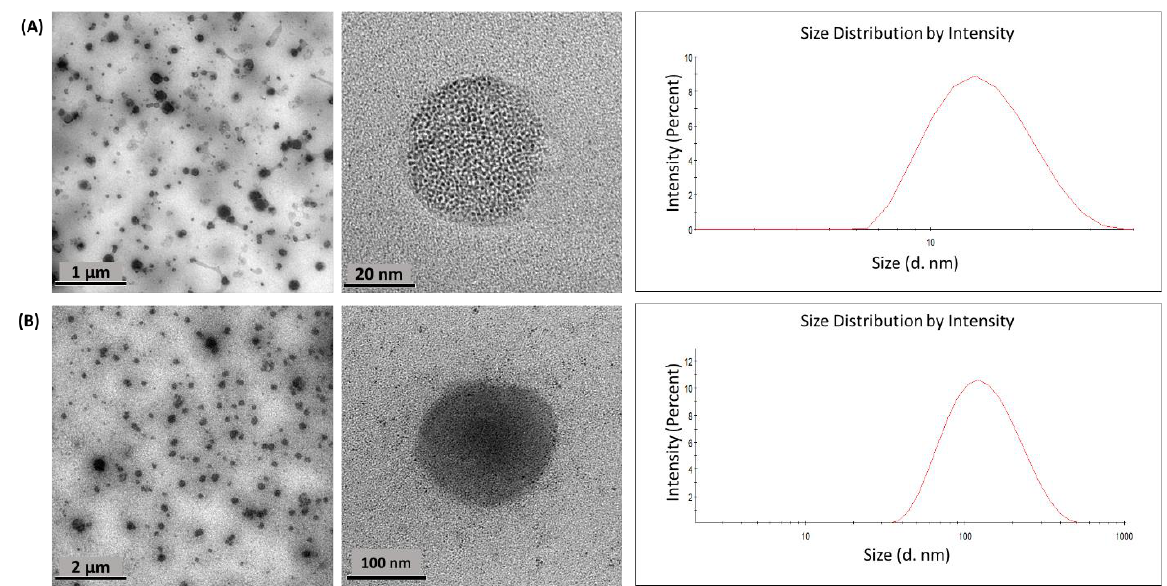
Figure 13. HR-TEM micrographs and histogram size distributions of ( A ) F-1 and ( B ) F-2.